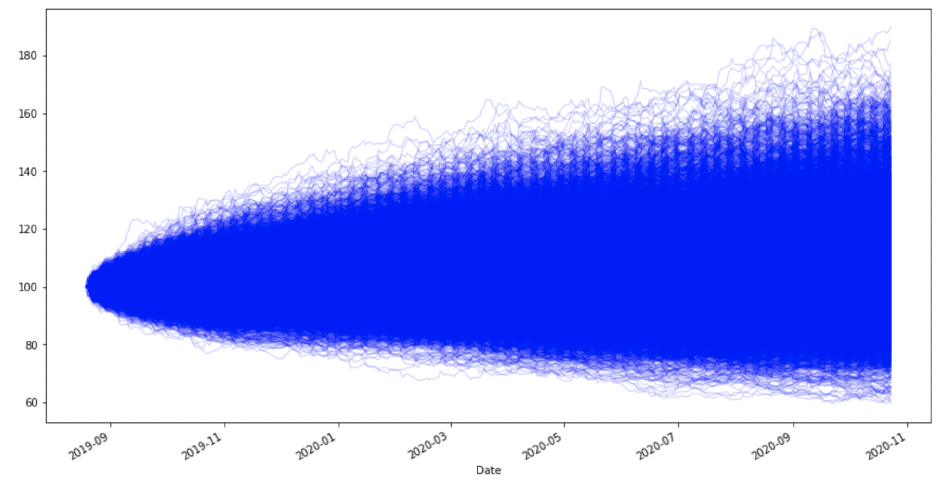
Figure 9. Monte Carlo simulations for the VolTarget portfolio with forecast volatility with VT set to 13% (source: authors’ calculations).